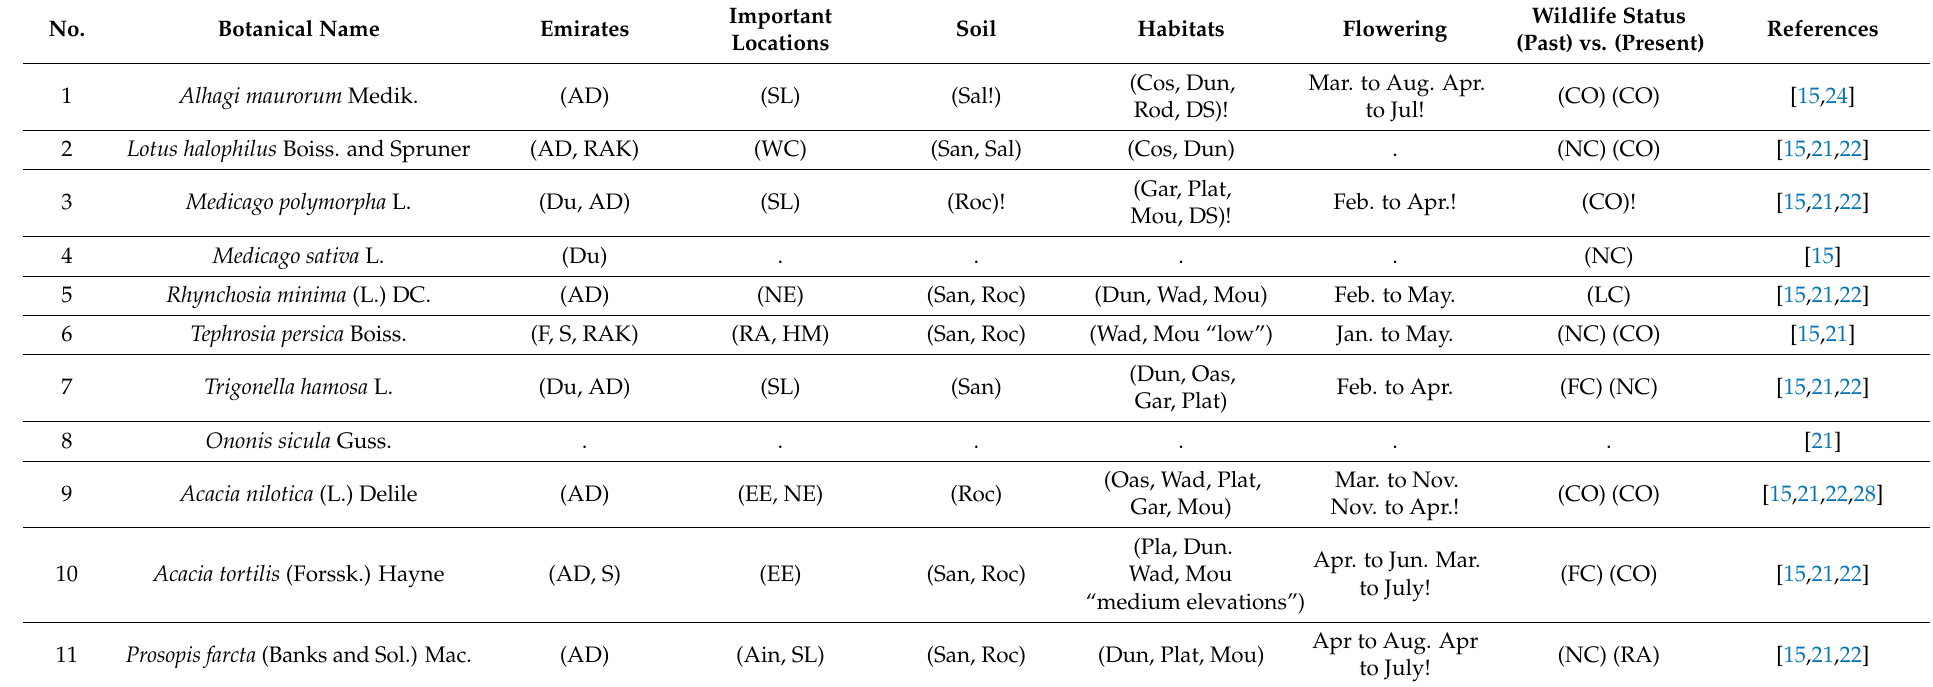
Table 6. Location of the UAE EO-bearing plants of